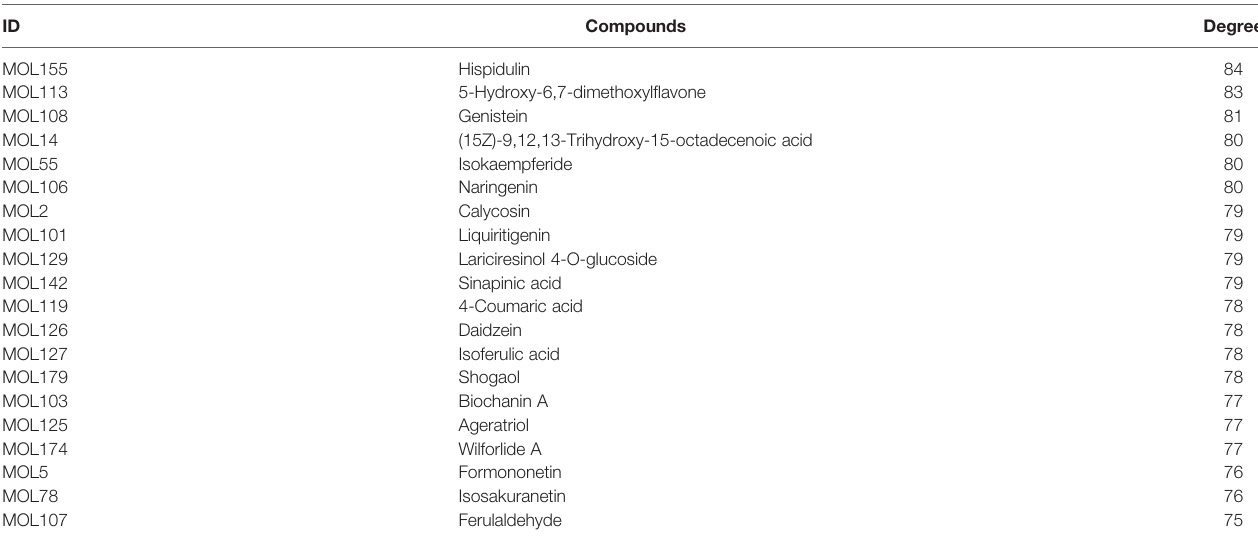
TABLE 1 | The top 20 components of HMMCR by